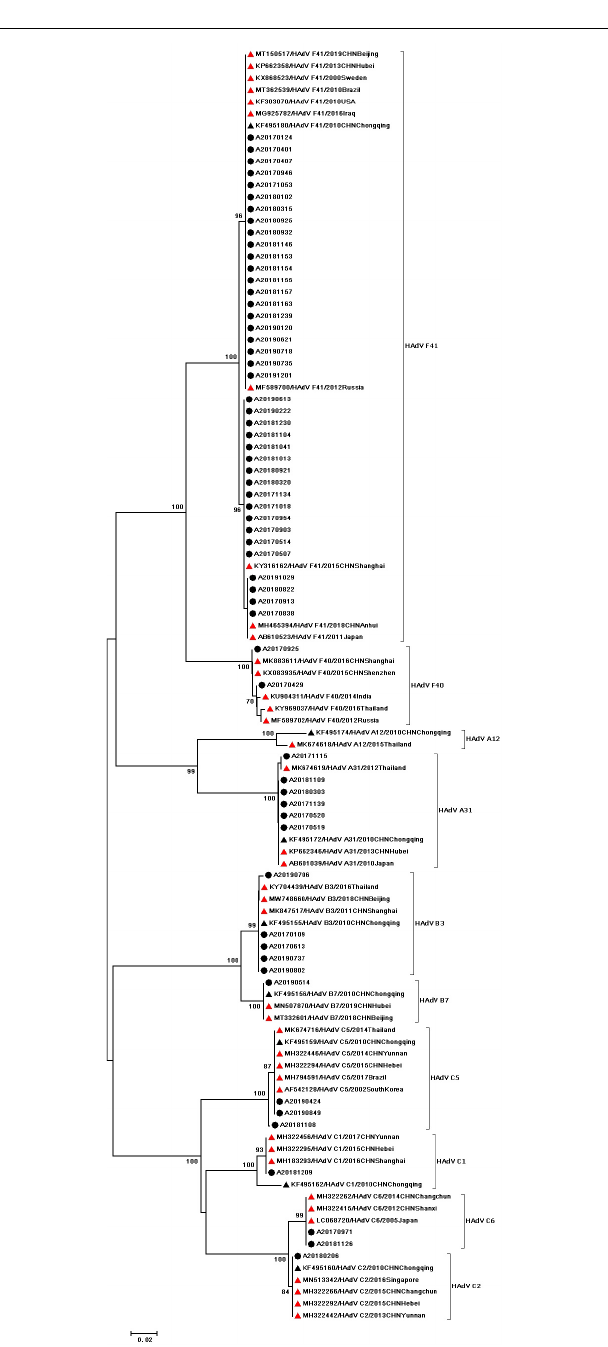
FIGURE 2 | Phylogenetic tree of HAdV detected in Chongqing based on partial nucleotide sequences (482 bp) of the exon gene. The dendrogram was constructed by the maximum likelihood method with the Kimura two-parameter model in MEGA 7.0. Numbers at each node represents bootstrap values obtained with 1,000 replicates ( > 70 are shown). The scale bar represents the unit for the expected number of substitutions per site. Strains from the present study (designed A/year/month/number) are labeled with a black circle. Red triangles indicate reference strains (including accession number, genotype, year, and location). Black triangles indicate previously reported strains from Chongqing (including accession number, genotype, year, and location).